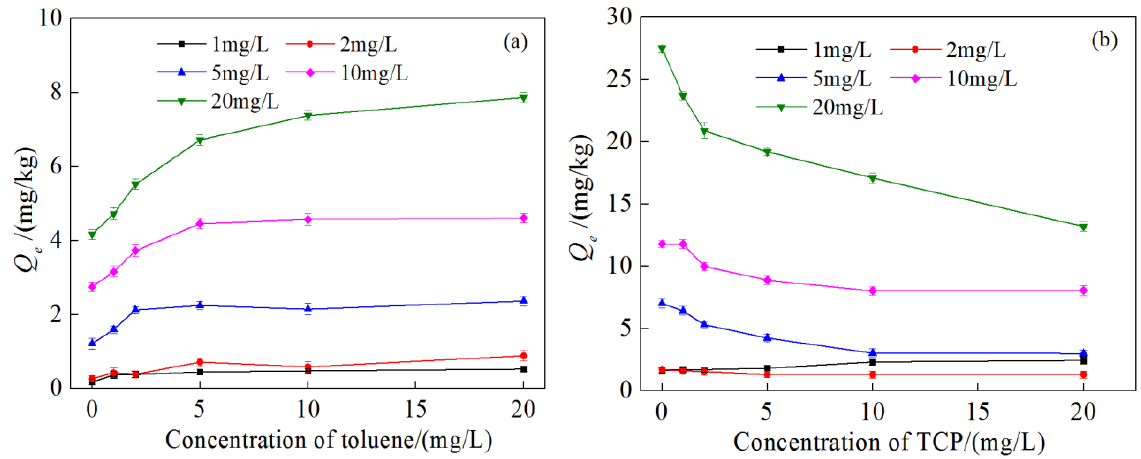
Figure 5. Competitive adsorption of TCP and toluene on the aquifer medium. (The initial concen- tration of the target compound and coexisting solute was 1, 2, 5, 10, and 20 mg/L, respectively. A total of 5 g of sand was added to 25 mL of pollutant solution.) ( a ) Effect of toluene on the adsorption of TCP with different concentrations; ( b ) Effect of TCP on the adsorption of toluene with different concentrations.